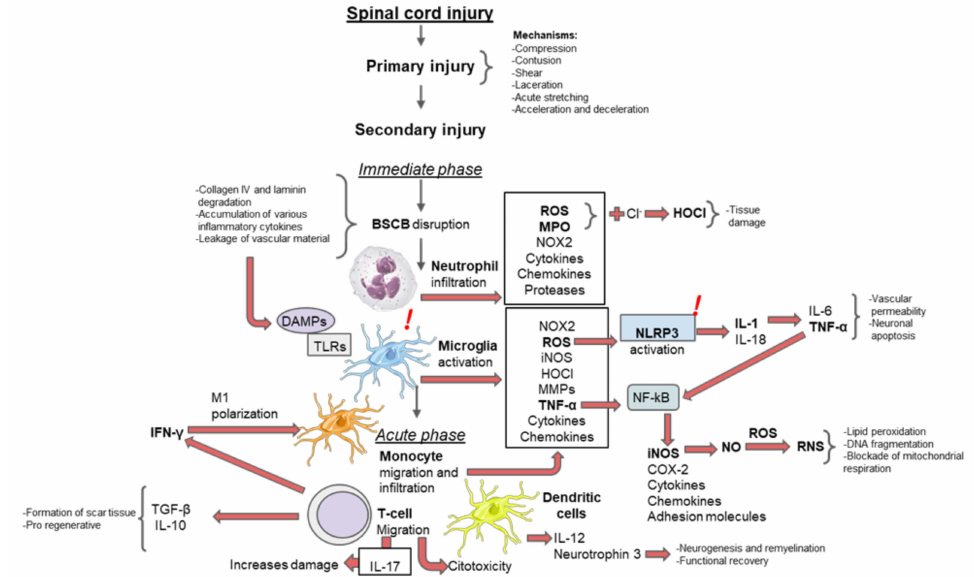
Figure 1. Main inflammatory events after SCI. The inflammatory mechanisms observed during secondary injury can be divided chronologically into immediate, acute, intermediate, and chronic phases. In the immediate phase, disruption of the BSCB leads to microglial activation. With mi- croglia, neutrophils infiltrate and release proinflammatory factors that cause tissue damage, vascular permeability, neuronal apoptosis, lipid peroxidation, DNA fragmentation, and blockade of mitochon- drial respiration. In the acute phase, macrophages migrate and infiltrate to promote the release of pro-inflammatory factors and help T cells to induce scar tissue formation. T cells also release pro- regenerative factors, while dendritic cells support functional recovery. Most treatments or therapeutic agents aim to regulate a particular inflammation process to improve the outcome of SCI. BSCB, blood– spinal cord barrier; Cl − , chloride; COX-2, cyclooxygenase-2; DAMPs, damage-associated molecular patterns; DNA, deoxyribonucleic acid; HOCl, hypochlorous acid; IFN- γ , interferon-gamma; IL-1 β , interleukin-1 beta; IL-4, interleukin-4; IL-6, interleukin-6; IL-10, interleukin-10; IL-12, interleukin-12; IL-13, interleukin-13; IL-18, interleukin-18; iNOS, inducible nitric oxide synthase; MMP, metallo- proteinase; MPO, myeloperoxidase; NLRP3, NACHT, LRR, and PYD domain-containing proteins 3; NF-kB, nuclear factor-kappa beta; NO, nitric oxide; NOX2, nicotinamide adenine dinucleotide phos- phate (NADPH) oxidase 2; RNS, reactive nitrogen species; ROS, reactive oxygen species; TGF- β , transforming growth factor-beta; TLRs, toll-like receptors; TNF- α , tumor necrosis